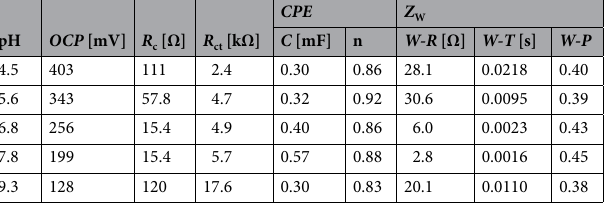
Table 2. EIS data fitting results with equivalent circuit in Fig. 5(e). R c represents the cell resistance, Z W the diffusion impedance, R ct the charge transfer resistance and CPE the interfacial